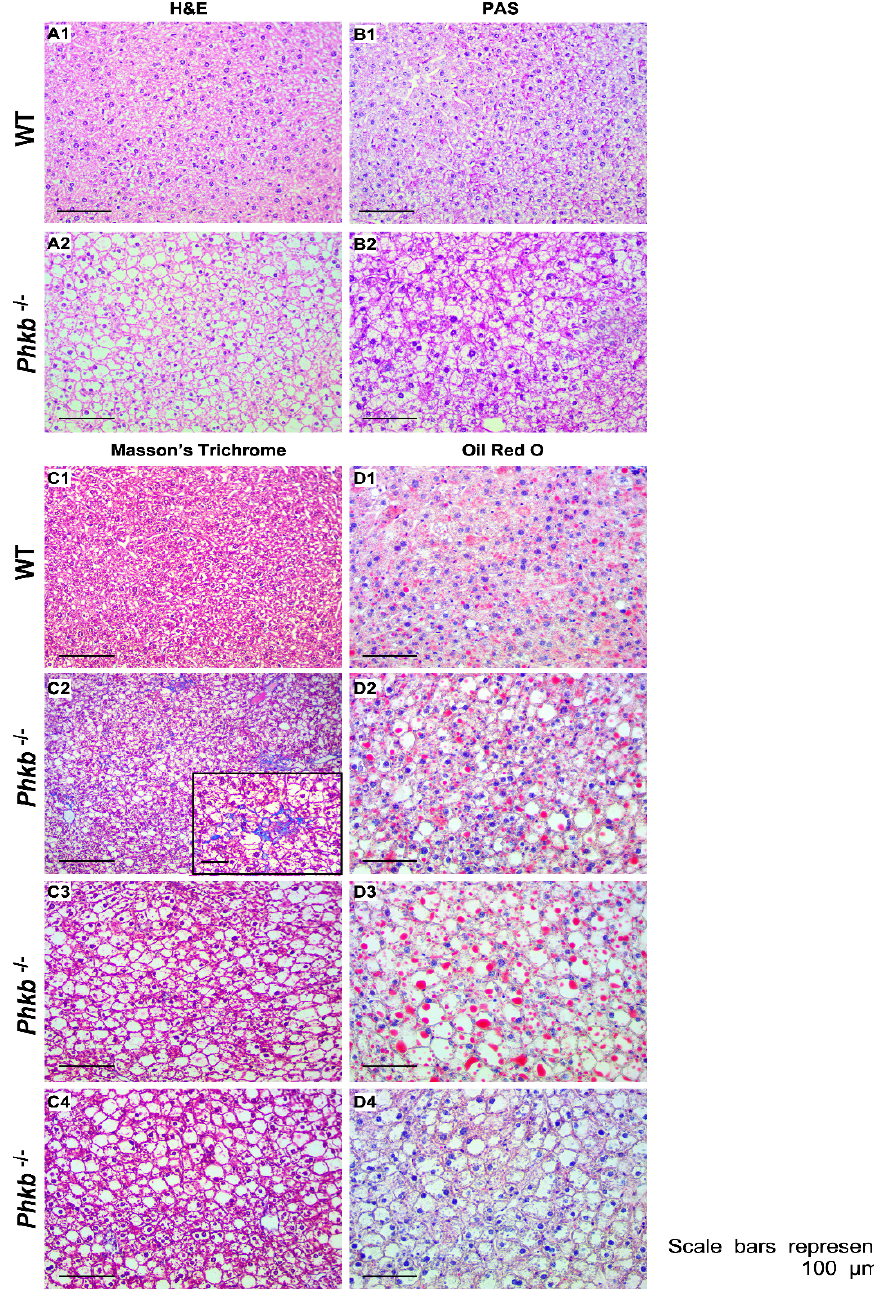
Figure 4. Histologic analysis of livers from WT and Phkb − / − mice. Representative images of liver sec- tions stained with H&E, PAS, Masson’s trichrome, and Oil Red O in old WT mice ( A1 , B1 , C1 , D1 ), old Phkb − / − mice ( A2 , B2 , C2 – C4 , D2 – D4 ). With Masson’s Trichrome staining, an individual old Phkb − / −